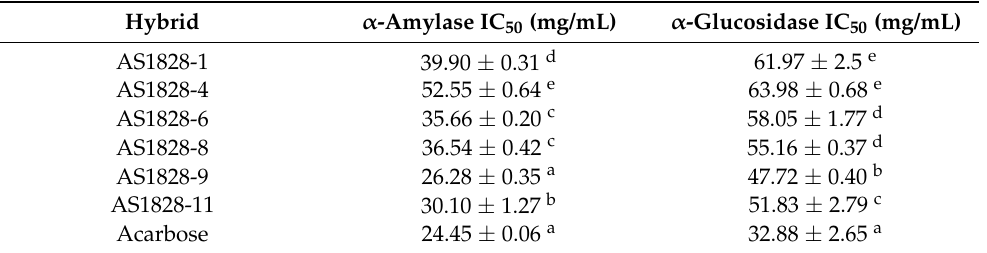
Table 4. Alpha-amylase and α -glucosidase IC 50 of six pipeline Striga -resistant yellow-orange maize hybrids.